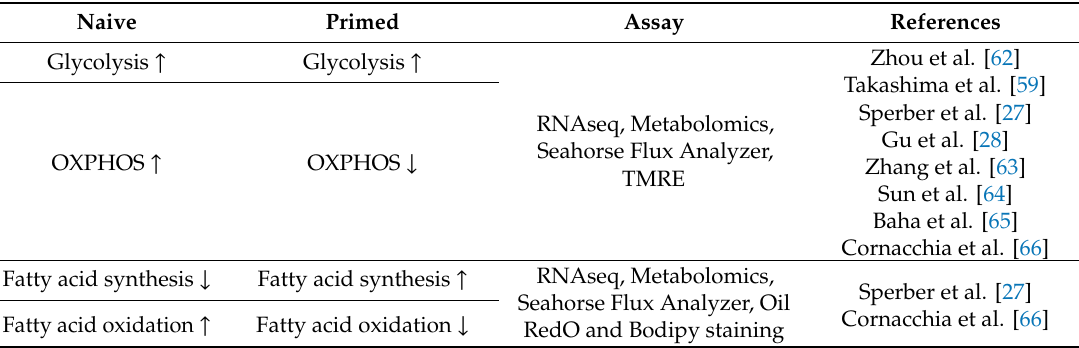
Table 2. Metabolic di ff erences between naïve and primed pluripotent stem cells.